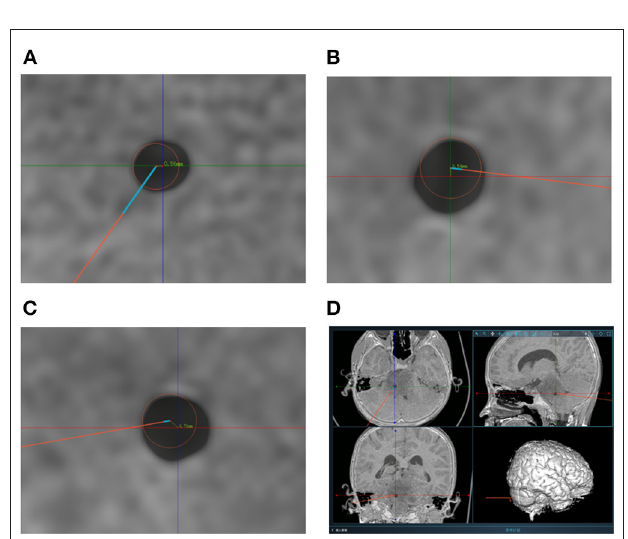
FIGURE 4 | (A–C) Measurement of target point error based on postoperative CT scanning. The centers of the red circles represent the target points planned preoperatively. The TPEs are computed based on the errors from axial position, coronal position and sagittal position respectively. (D) The picture shows the measurement of one of the patients. And the TPEs were 0.52, 0.54, and 0.76mm, respectively. The actual TPE was 1.07mm.